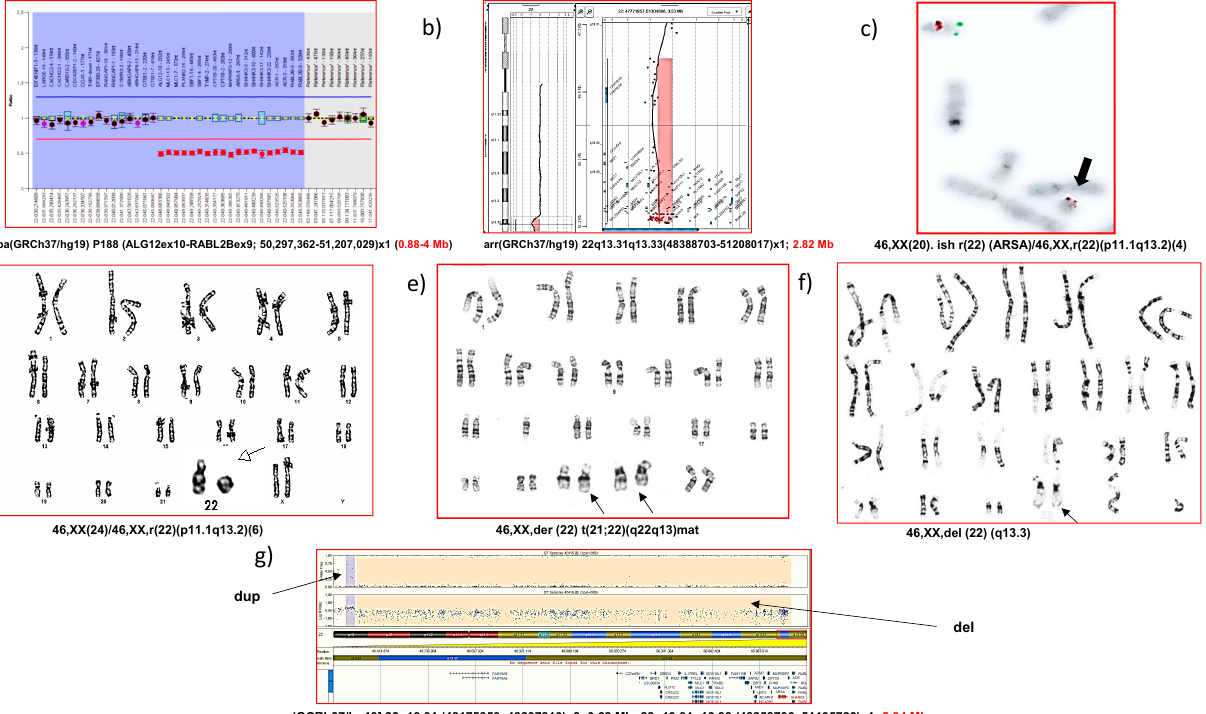
Figure 1. Different genetic rearrangements present in PMS, established by different cytoge- netic/molecular techniques: ( a ) interstitial deletion by MLPA; ( b ) terminal deletion by microarray CGH; ( c ) terminal deletion and ring chromosome by FISH; ( d ) terminal deletion and ring chromo- some by karyotype (GTL bands), ( e ) unbalanced translocation by karyotype, ( f ) terminal deletion by karyotype, ( g ) terminal deletion and other adjacent SNP-array